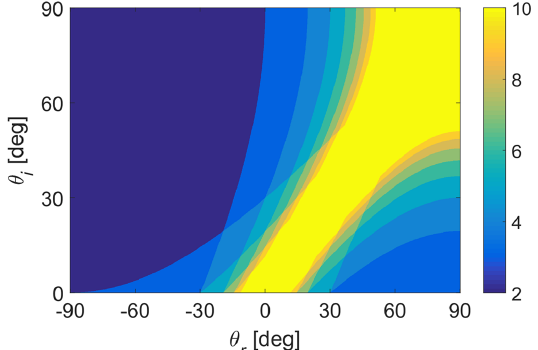
FIG. 2. A plot showing N as a function of ð θ